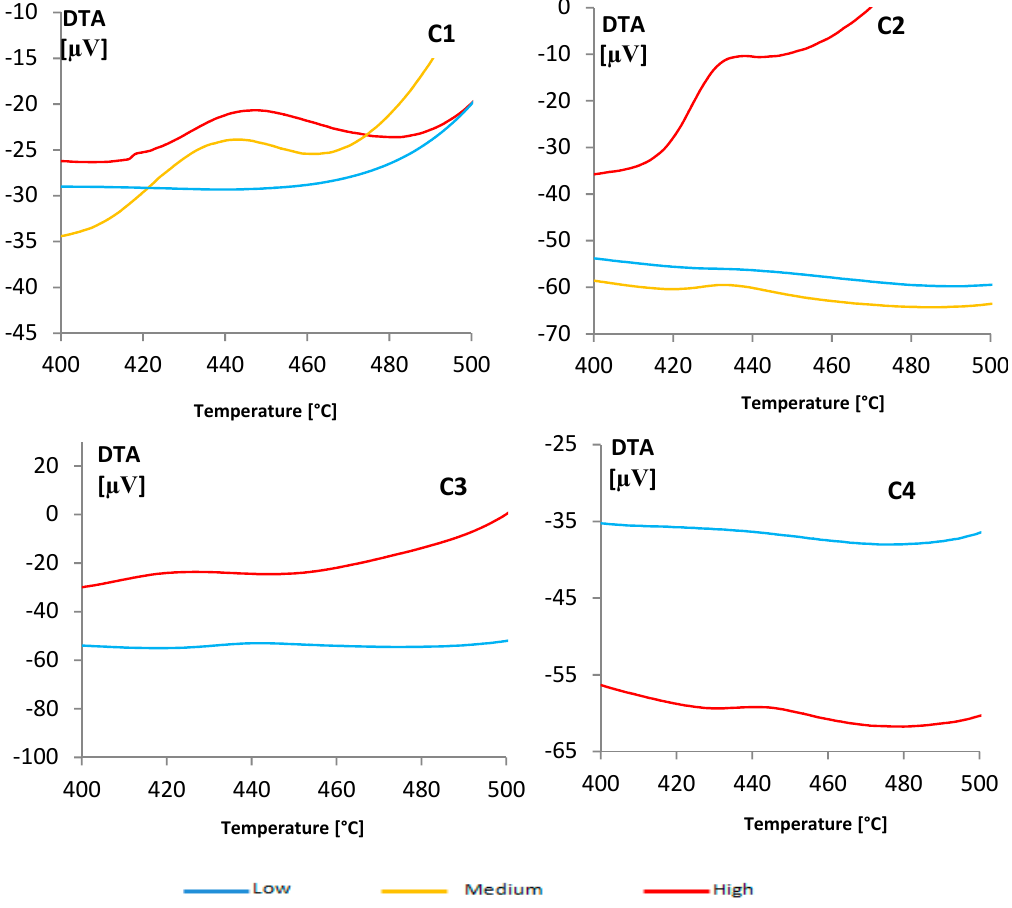
Figure 10. DTA curves of different columns at different heights.